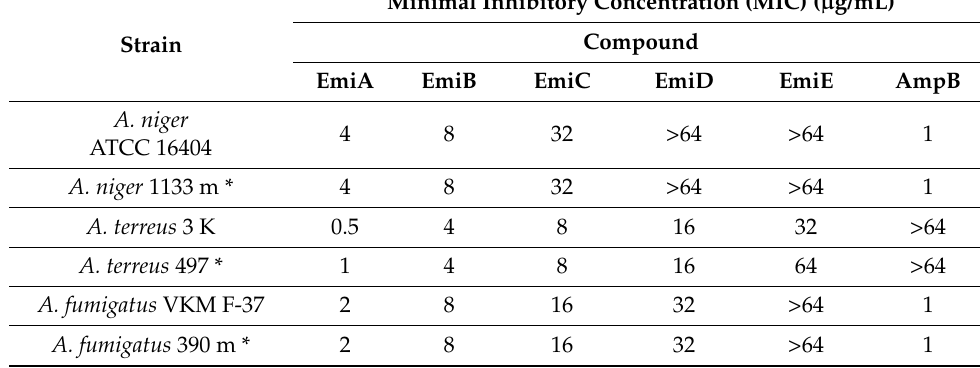
Table 4. Minimal inhibitory concentrations (MICs) of the emericellipsins antimicrobial peptides (AMPs) against different clinical and opportunistic